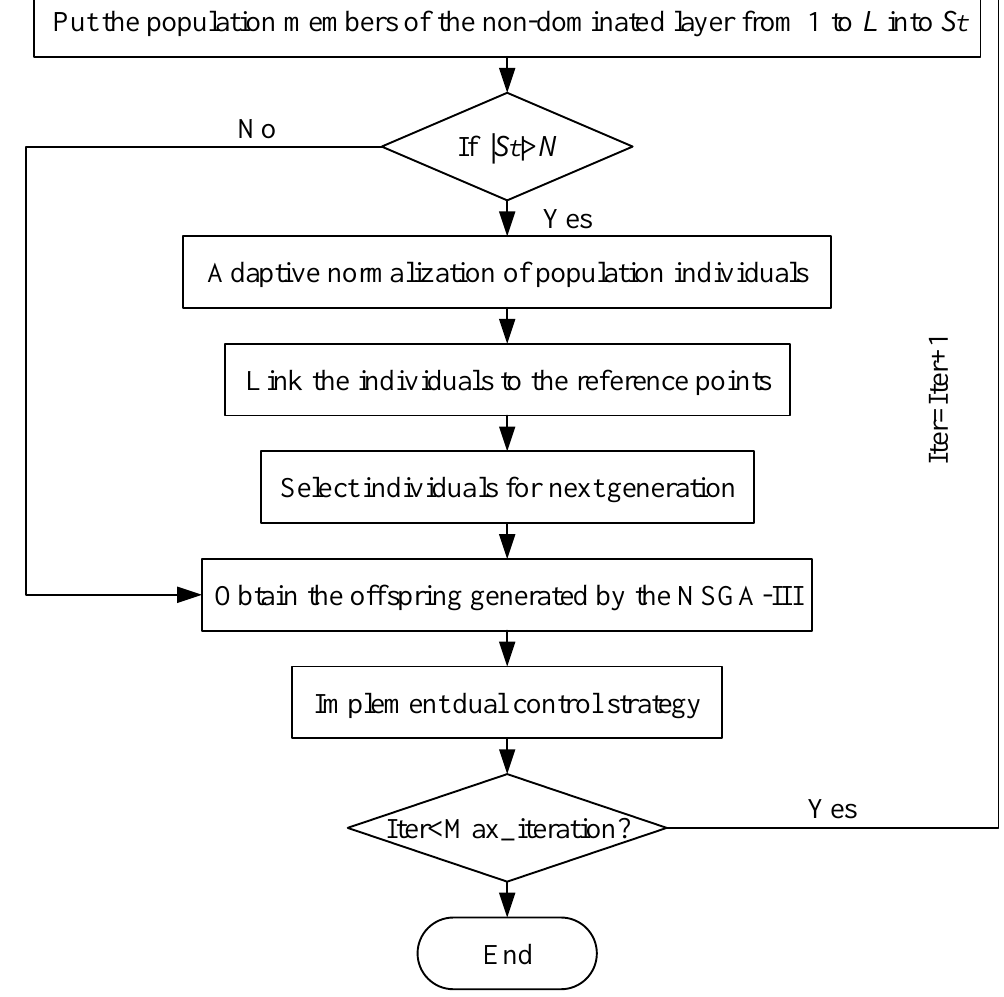
Figure 3. The flowchart of